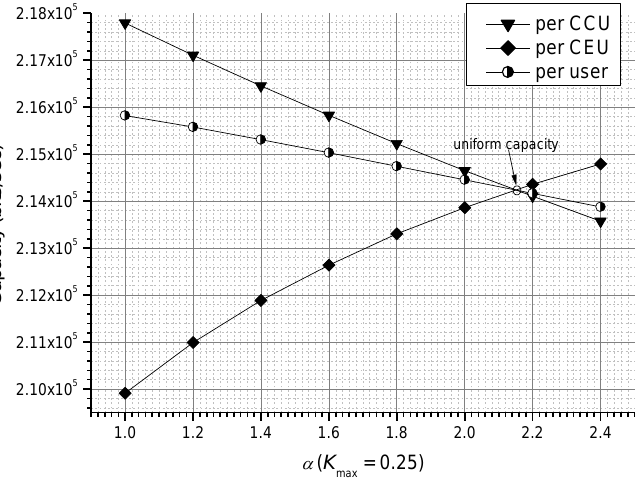
Figure 4. Capacity comparison as a function of 𝛼 for a small 𝐾 max (= 0.25) in SU-network MIMO.